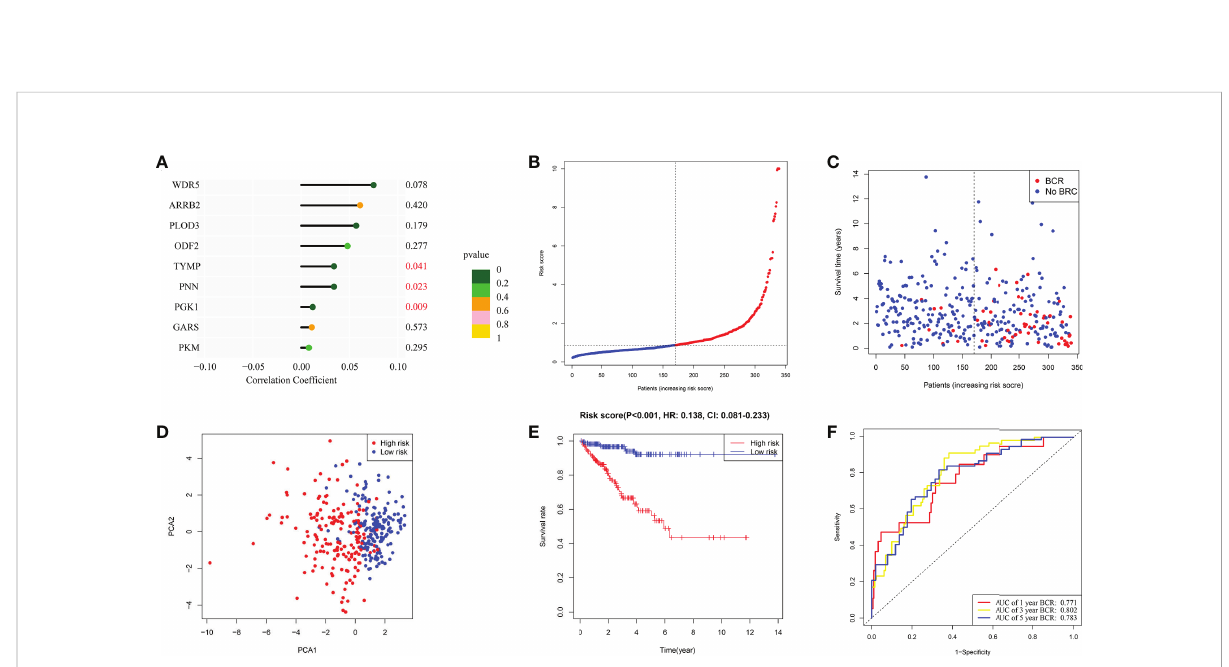
FIGURE 3 The construction of risk signature in TCGA. (A) Coef fi cient of 9 genes in this signature. (B, C) Distribution, BFFS status and risk score of PRAD patients. (D) PCA graph for PRAD patients. (E) KM curve for BFFS of PRAD patients based on high and low-risk groups. (F) ROC curves of 1, 3, 5- year for this signature.